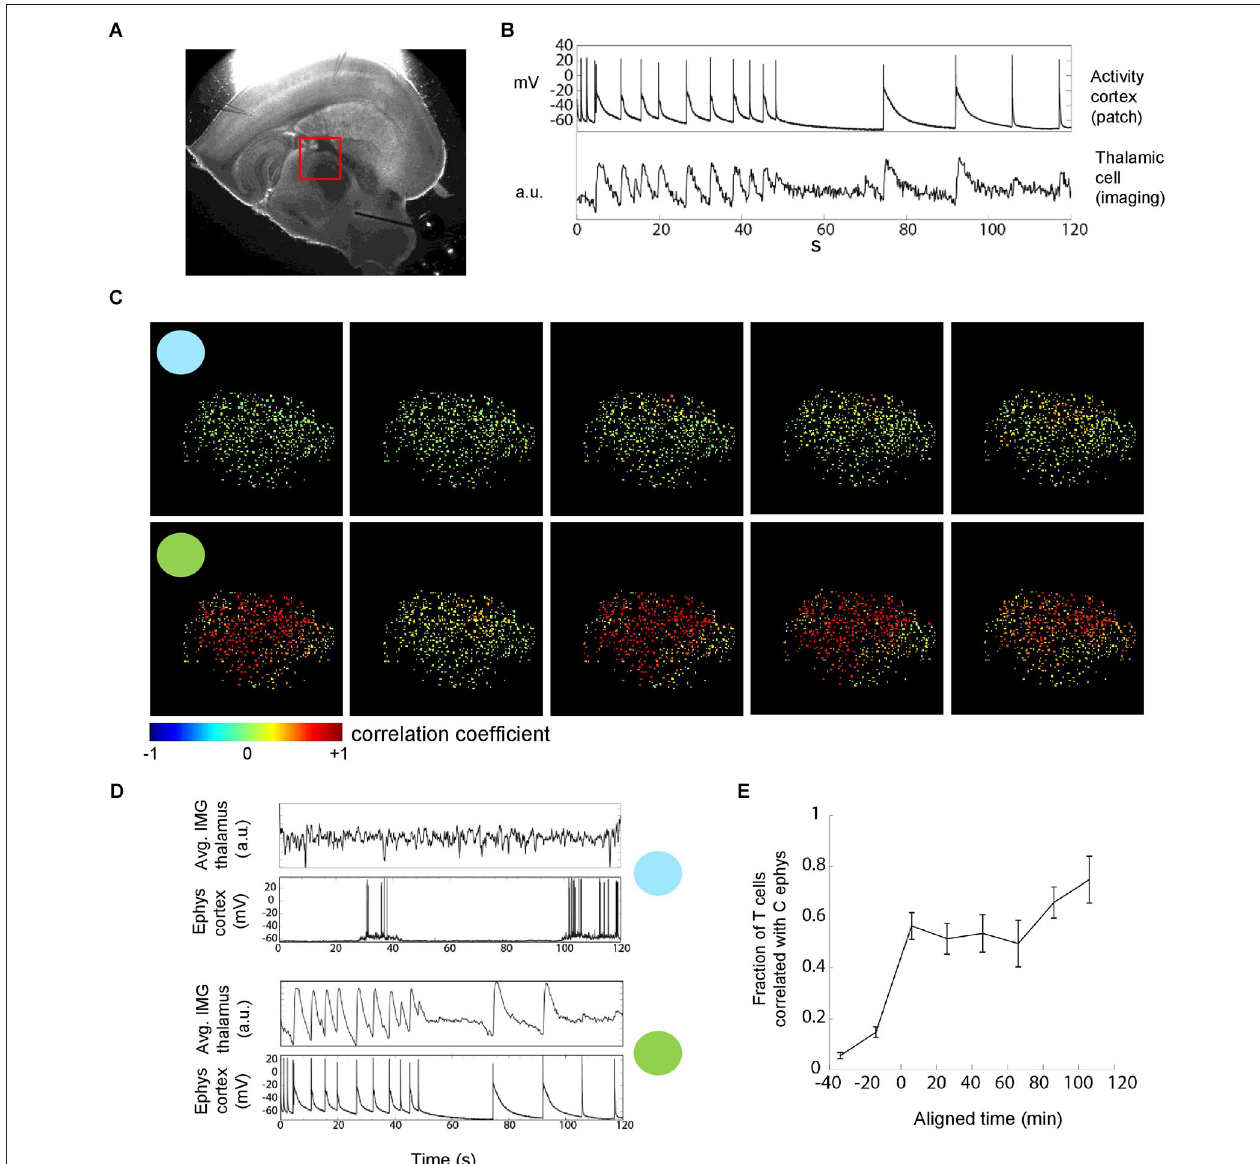
FIGURE 3 | Thalamic neuronal activity during epileptiform discharges . (A) Thalamic imaging (red box, field of view) and cortical